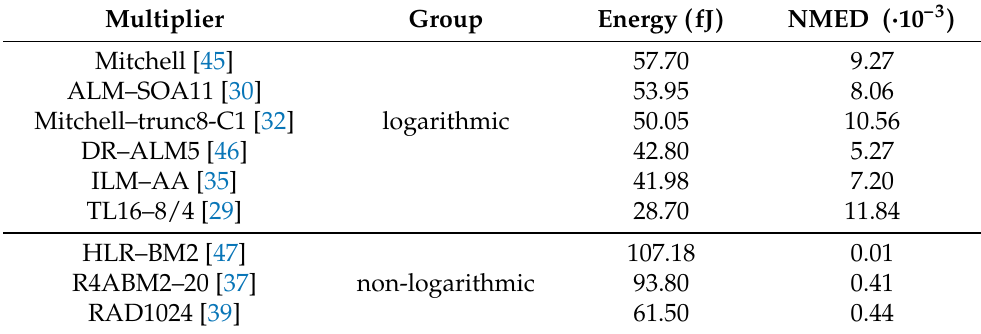
Table 1. Overview of the state-of-the-art 16-bit approximate multipliers